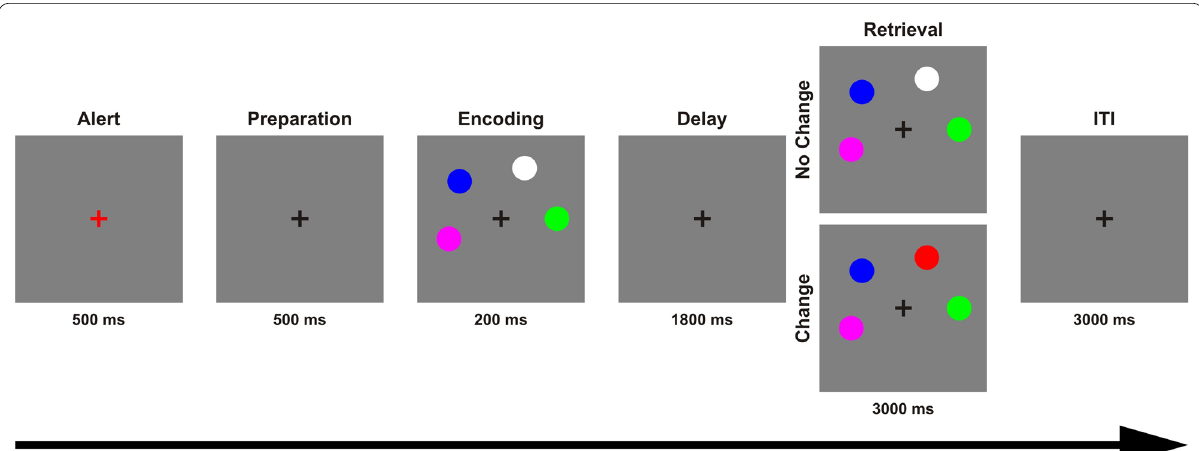
Fig. 1 The change detection task used to assess working memory capacity. Each trial began with the alert phase, during which the fixation cross turned to red for 500 ms. This was followed by a preparation phase of 500 ms. During the encoding phase a sample array of four colored circles was presented for 200 ms. During the delay phase, the black fixation cross remained on the screen for 1800 ms. The whole‑display recognition test array followed, in which participants had a maximum duration of 3000 ms to decide if the test array was identical to the sample array presented in the encoding phase, or if one of the circles had changed color